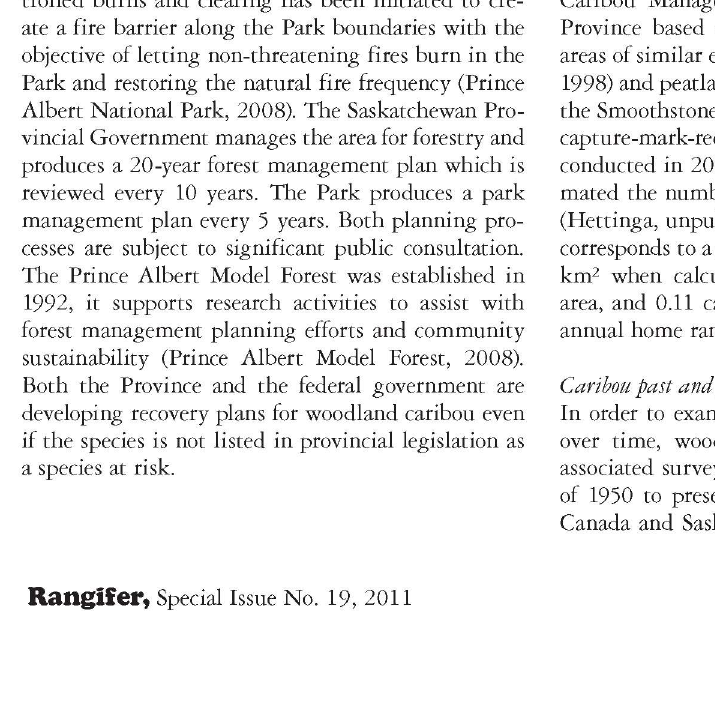
Smoothstone-Wapaweka Woodland Caribou Management